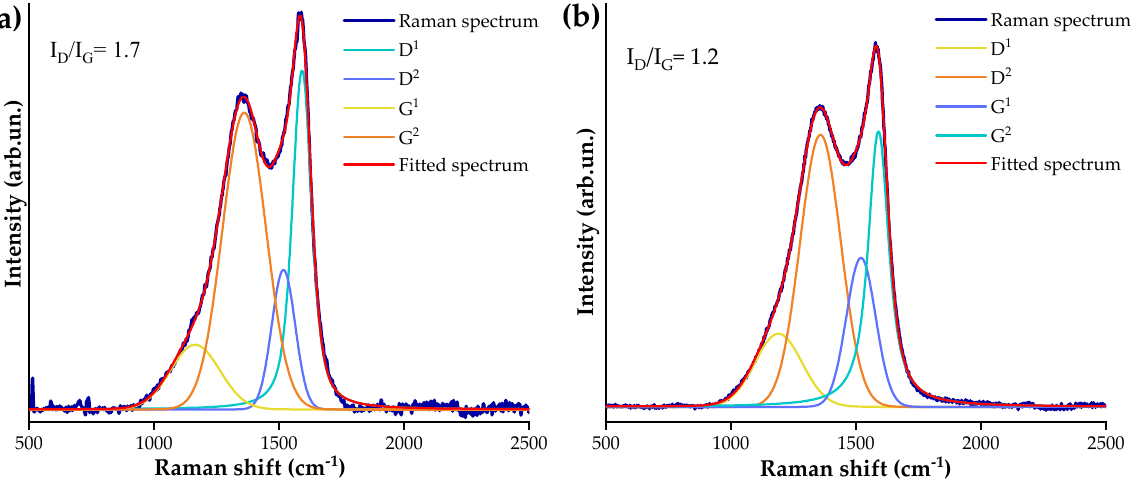
Figure 3. Raman spectra of C-surgical ( a ) and C-FFP2 ( b ) in the range between 500 and 2500 cm − 1 . The morphology of the pyrolytic char produced from the surgical FMs (Figure 4a,b) was characterized by particles having sizes in the range of a hundred microns with few submicrometric carbon particles attached, similar to what was observed by Yousef et al. on other FM-derived carbon materials [47]. The particle size distribution of the FFP2 FMs was slightly different, with an average size lower than 1 µ m. The different morphology was in good agreement with the specific surface area, which was 2.1 m 2 g − 1 in the case of C-surgical and 10.2 m 2 g − 1 in the case of C-FFP2, as measured by N 2 physisorption analysis at − 196 °C.